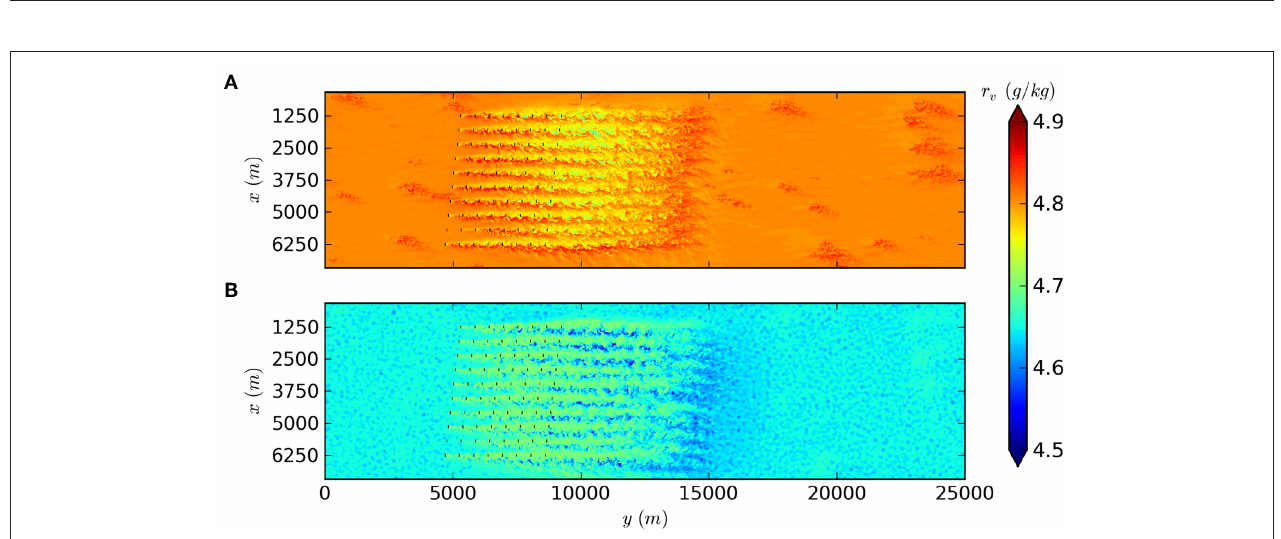
FIGURE 8 | Horizontal cross-sections at 30 m (A) and 110 m (B) above the sea of the relative humidity RH . The black plain lines (–) delimits the locations of wind turbines.